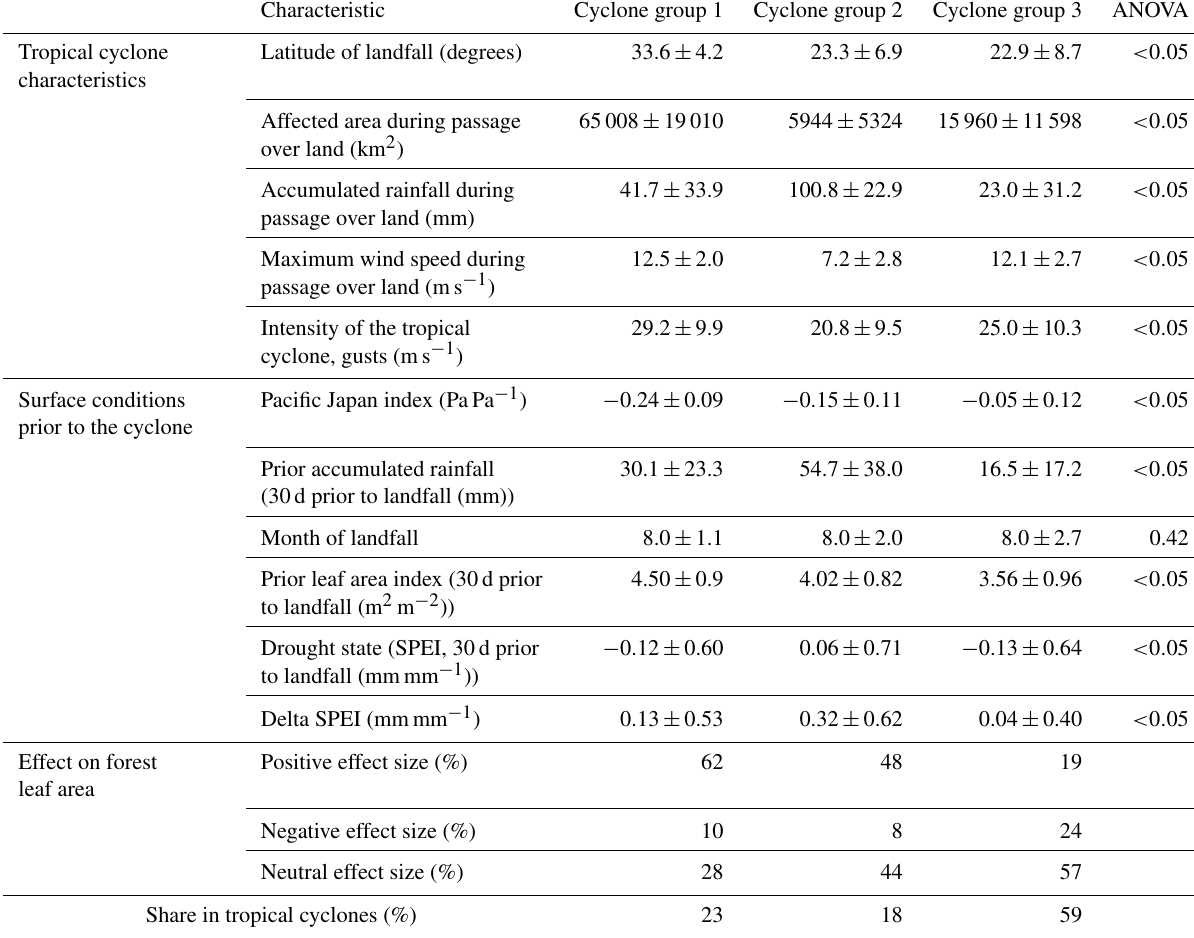
Table 1. Median and standard deviation for five cyclone characteristics and six surface characteristics mainly prior to the passage of the 140 ± 41 tropical cyclones that passed the quality checks. Cyclone groups 1 to 3 were the outcome of a decision tree (Fig. A4) that classified the four main factors of factorial analysis of the land surface characteristics, cyclone characteristics, and effect sizes to identify collinearity (Table A2). The column labeled with ANOVA shows the p value of an ANOVA test to test for significant differences between cyclone